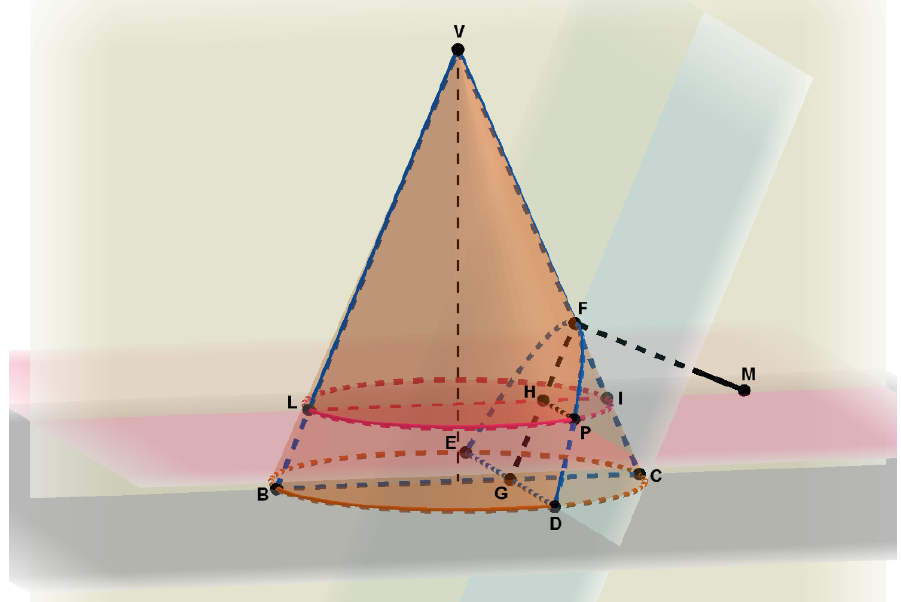
Figure 3. Final construction related to Apollonius’ Proposition I 11.